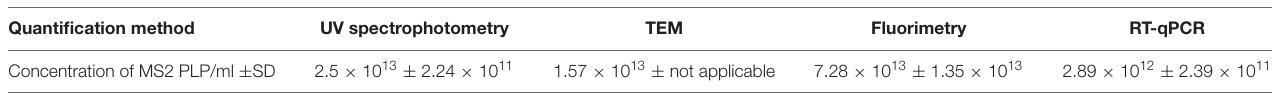
TABLE 2 | The results of MS2 phage-like particles (MS2 PLP) quantification experiments.